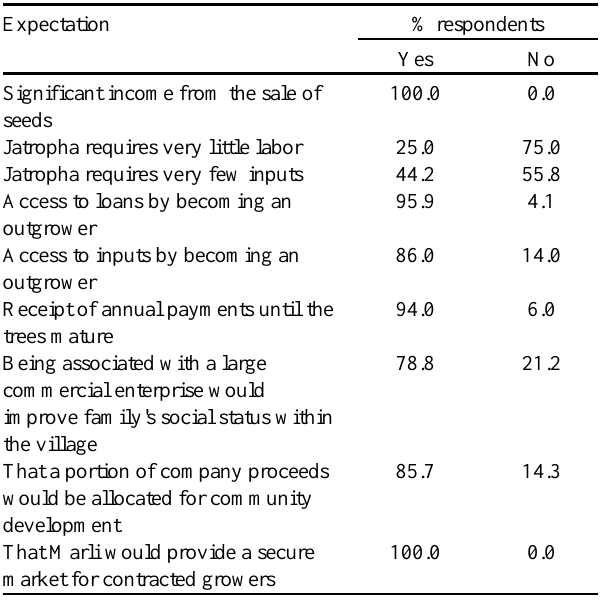
Table 2 . Farmer expectations at the time of signing production agreements in Chinsali and Mungwi Districts (n =